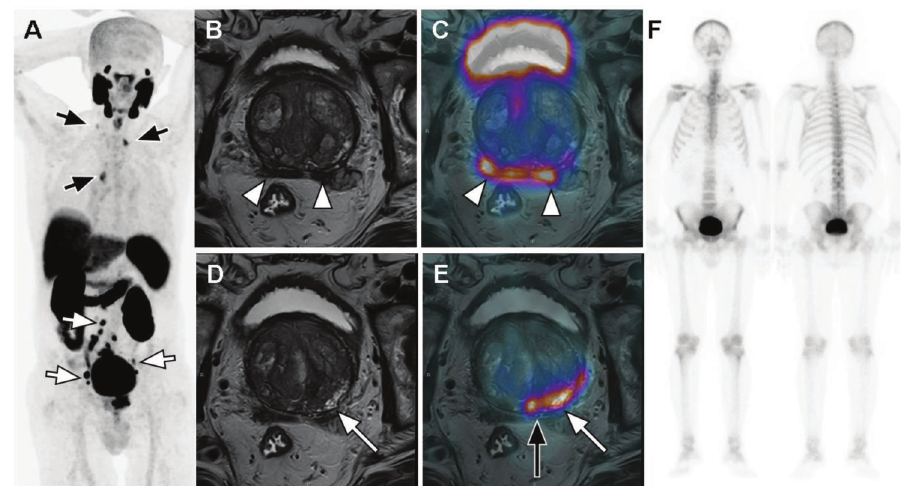
Figure 1 - PSMA PET/MRI for initial staging of a 77-year-old high-risk PCa patient with a Gleason score of 7 (3 + 4) and a PSA of 44.0 ng/dL. The staging would be T3bN1M0 if the patient was assessed with conventional imaging, namely, mpMRI (B and D) and BS (F). PSMA PET (coronal maximum intensity projection (MIP)inf A and fused PET/MR in C and E) clearly depicts more extensive pelvic (white arrows in A), extrapelvic thoracic and right inferior cervical nodal involvement (black arrows in A), upstaging the patient to T3bN1M1a. The incre- mental value of multimodal assessment is also seen in terms of the patient ’ s T status. There is concordance between PSMA PET and MRI regarding bilateral seminal vesicle involvement encompassing the whole right seminal vesicle and the medial portion of the left seminal vesicle (white arrowheads in B and C), whereas PSMA PET/MRI revealed a more extensive (black long arrow in E) primary lesion in the left and median peripheral zones of base and midgland than mpMRI (white long arrows in D and